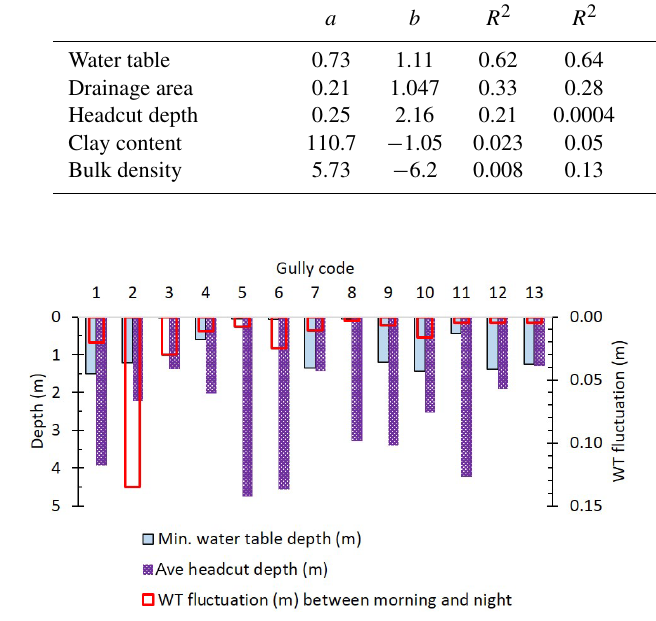
Figure 5. Comparison of minimum groundwater table depth, gully headcut depth, and the average groundwater table (WT) fluctuation between morning and night for the 13 study gullies in the Debre Mawi watershed, Ethiopia, for the 2013 rain